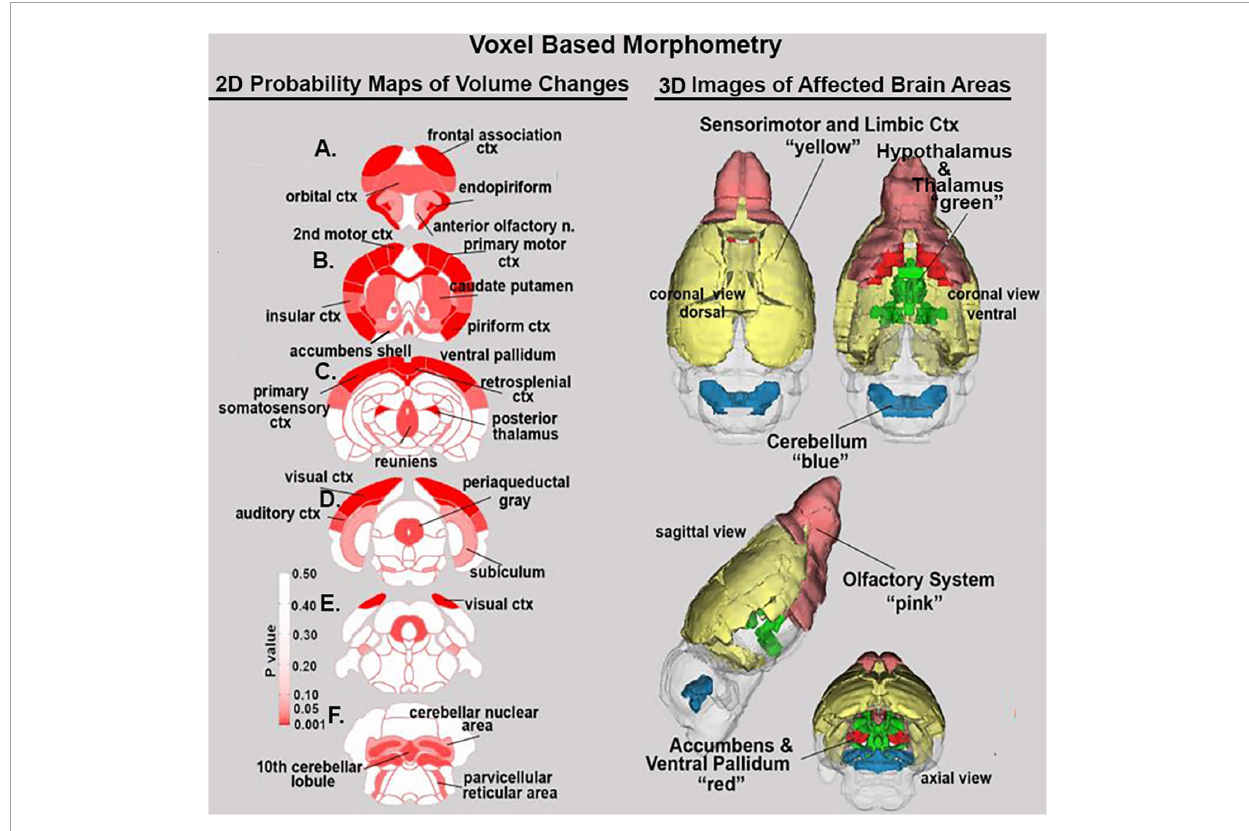
FIGURE1 Voxel based morphometry. The location of many of the brain areas listed in Table 1 are shown in the 2D heat maps and are summarized in the 3D color-coded reconstructions to the right.